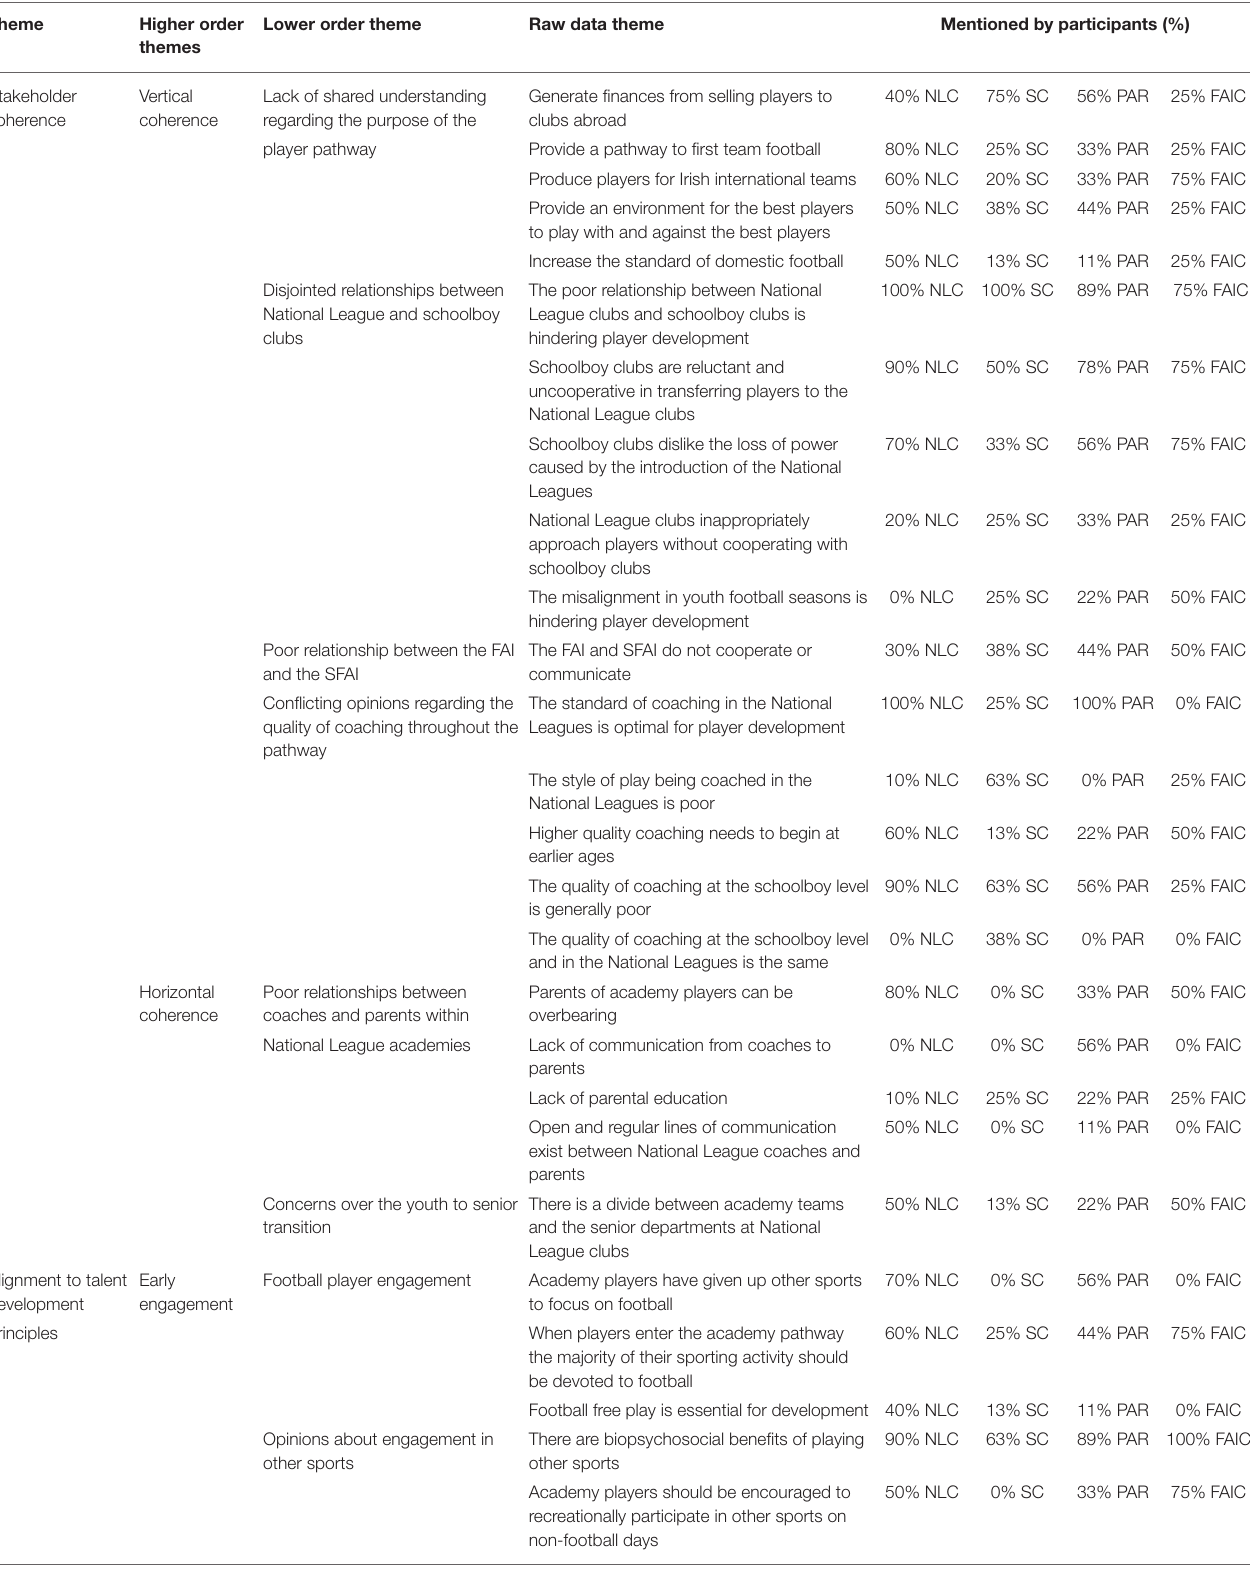
TABLE 1 | The themes, higher order themes, and lower order themes produced from the reflexive thematic